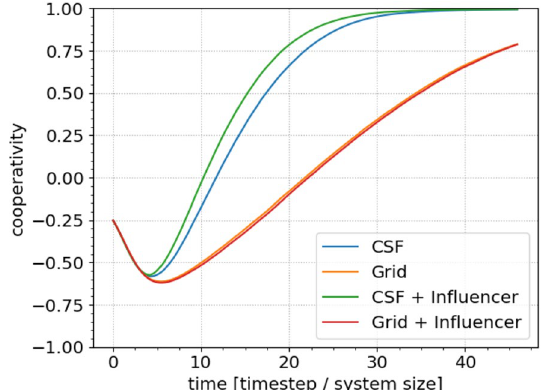
Figure 5. The average cooperativity as a function of time for different grid types with and without an influencer in the network. An influencer is a highly connected (in this case the most connected) node with an unwavering behaviour. We can see that the key property of an influencer is the first of these attributes, as their effect in a grid network is almost negligible.